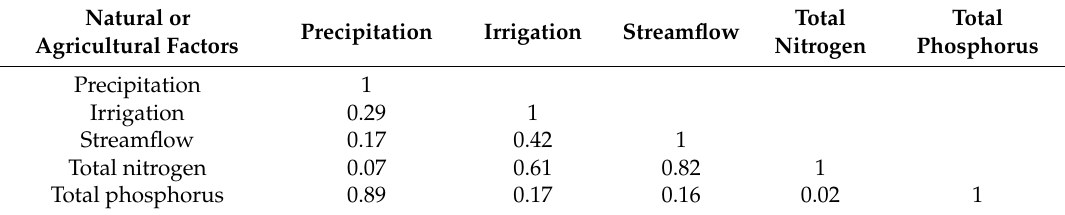
Table 3. Relationships between simulated monthly model outputs (significant correlations, p < 0.05). Natural